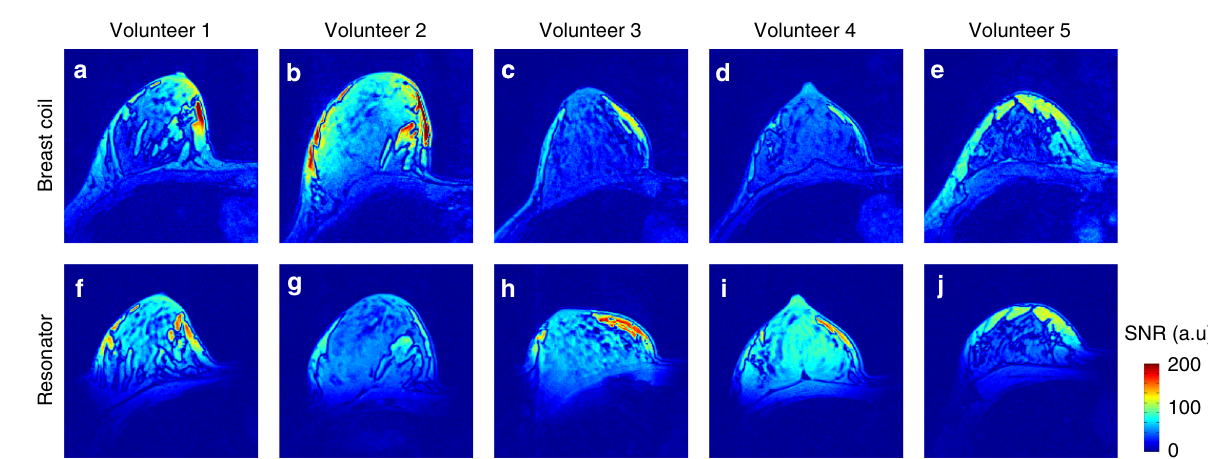
Fig. 4 The comparison of the performances of the conventional and targeted MRI for a standard MR sequence via signal-to-noise ratio (SNR) maps. During the conventional procedure ( a – e ), the MR signal was excited by a birdcage body coil and received by a 16-channel breast coil. In the targeted MRI concept ( f – j ), the birdcage coil was used for both transmitting and receiving in combination with the ceramic resonator.